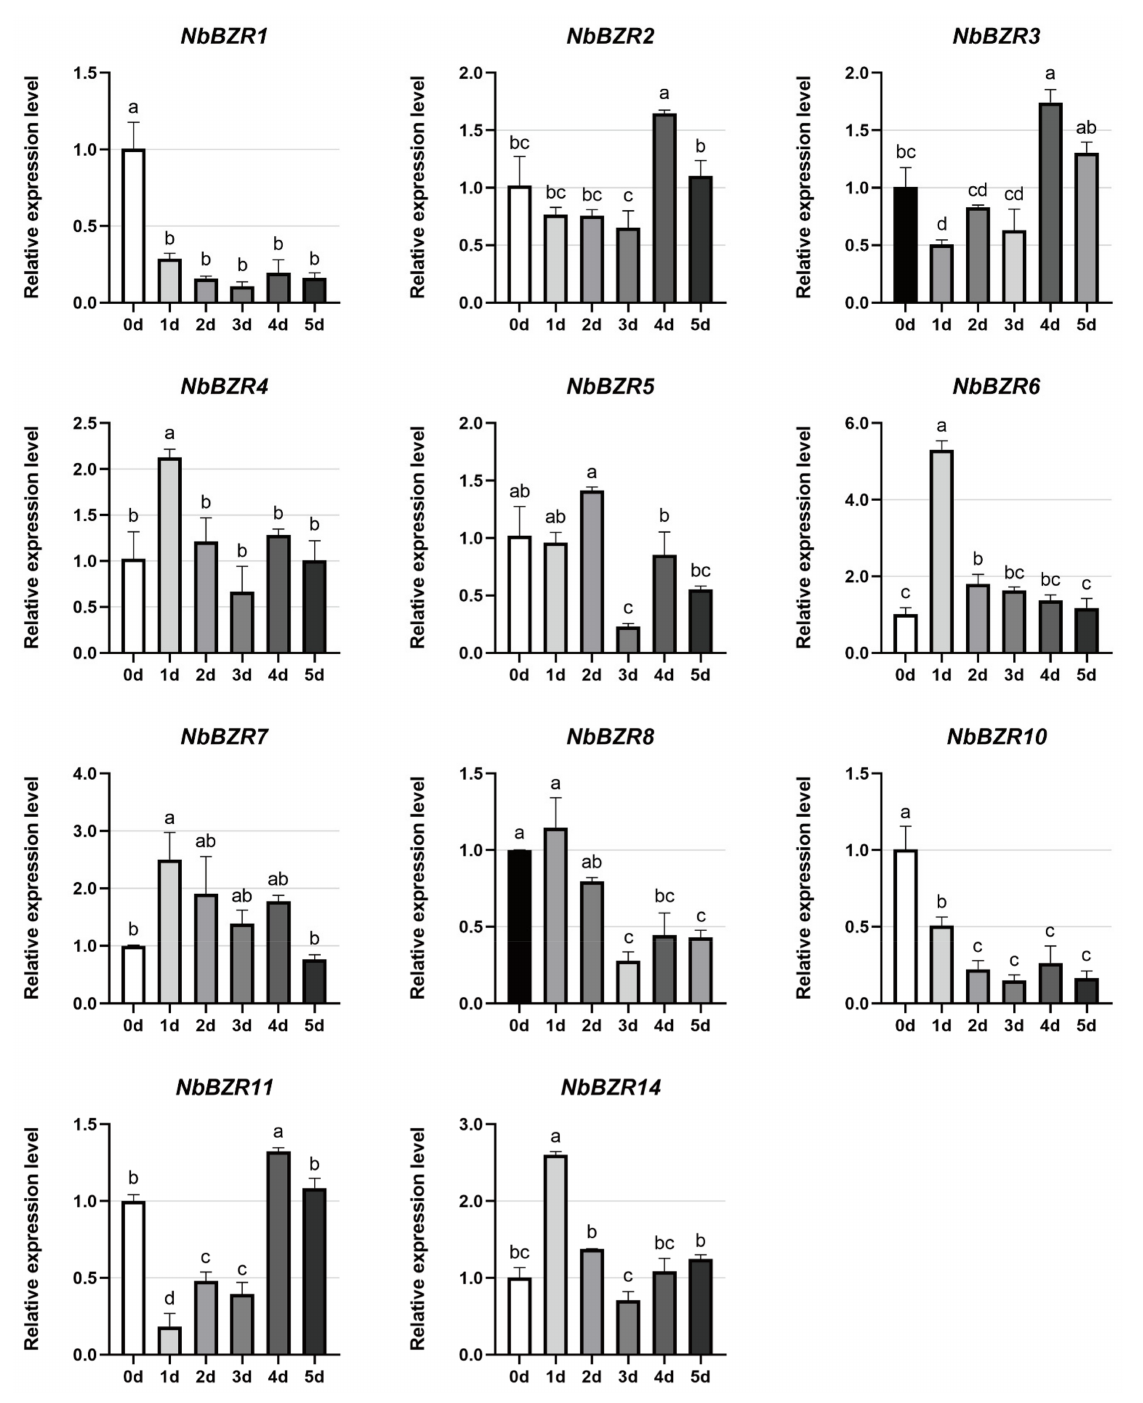
Figure 7. Expression analysis of NbBZRs after heat (0–5 days) stress. Gene expression was normalized to control unstressed expression level, which was assigned a value of 1. Data represent averages of three independent experiments ± SD. Standard errors are shown as bars above columns. Different letters indicate significant differences according to Tukey’s multiple comparisons test. Columns with different marked letters are significantly different ( p < 0.05), and those with the same marked letter or share a letter are not significantly